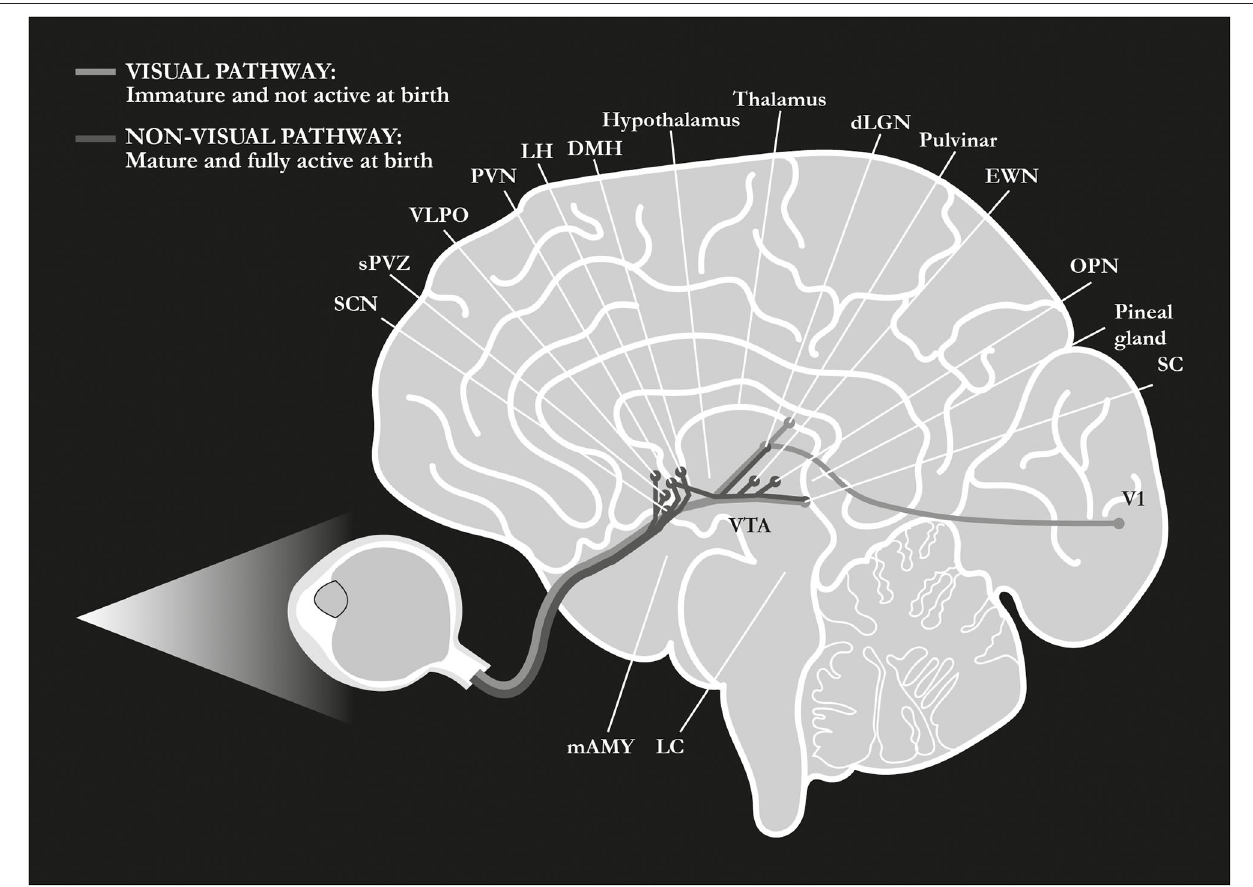
FIGURE 2 | Retinal pathways at birth. At birth, differently from the visual pathway, the non-visual pathway is mature and fully active, allowing for the transferal of the light signal from ipRGCs to many different centers of the brain. SCN, suprachiasmatic nucleus in the anterior hypothalamus; sPVZ, hypothalamic subparaventricular zone; VLPO, ventrolateral preoptic nucleus in the anterior hypothalamus; PVN, paraventricular nucleus of the hypothalamus; LH, lateral hypothalamus; DMH, dorso-medial nucleus of the hypothalamus; dLGN, dorso-lateral geniculate nucleus of the thalamus; EWN, Edinger-Westphal nucleus; OPN, olivary pretectal nucleus in the dorsal midbrain; SC, superior colliculus; V1, primary visual cortex; VTA, ventral tegmental area; LC, locus coeruleus; mAMY, medial amygdala. References in the